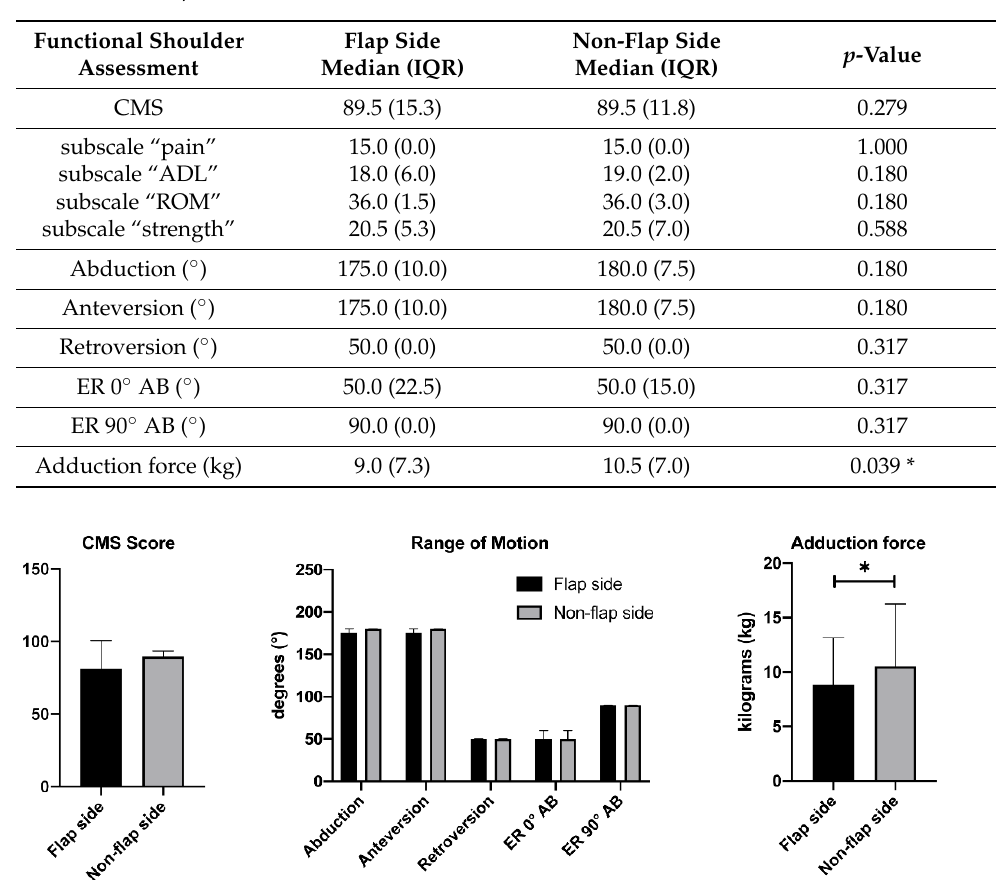
Table 4. Functional shoulder assessment results. A statistically significant difference was found in adduction force, p = 0.039 *.